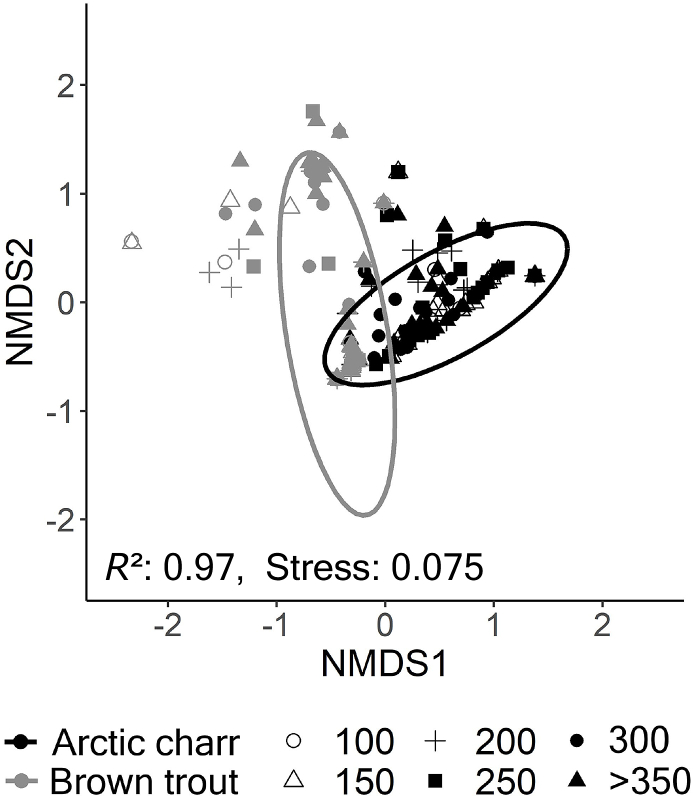
Differences in parasite community composition between Arctic charr and brown trout using nonmetric multidimensional scaling (NMDS) plot on Bray-Curtis distances, including 95% confidence interval ellipses. NMDS converged on a three-dimensional solution with an acceptable stress level.